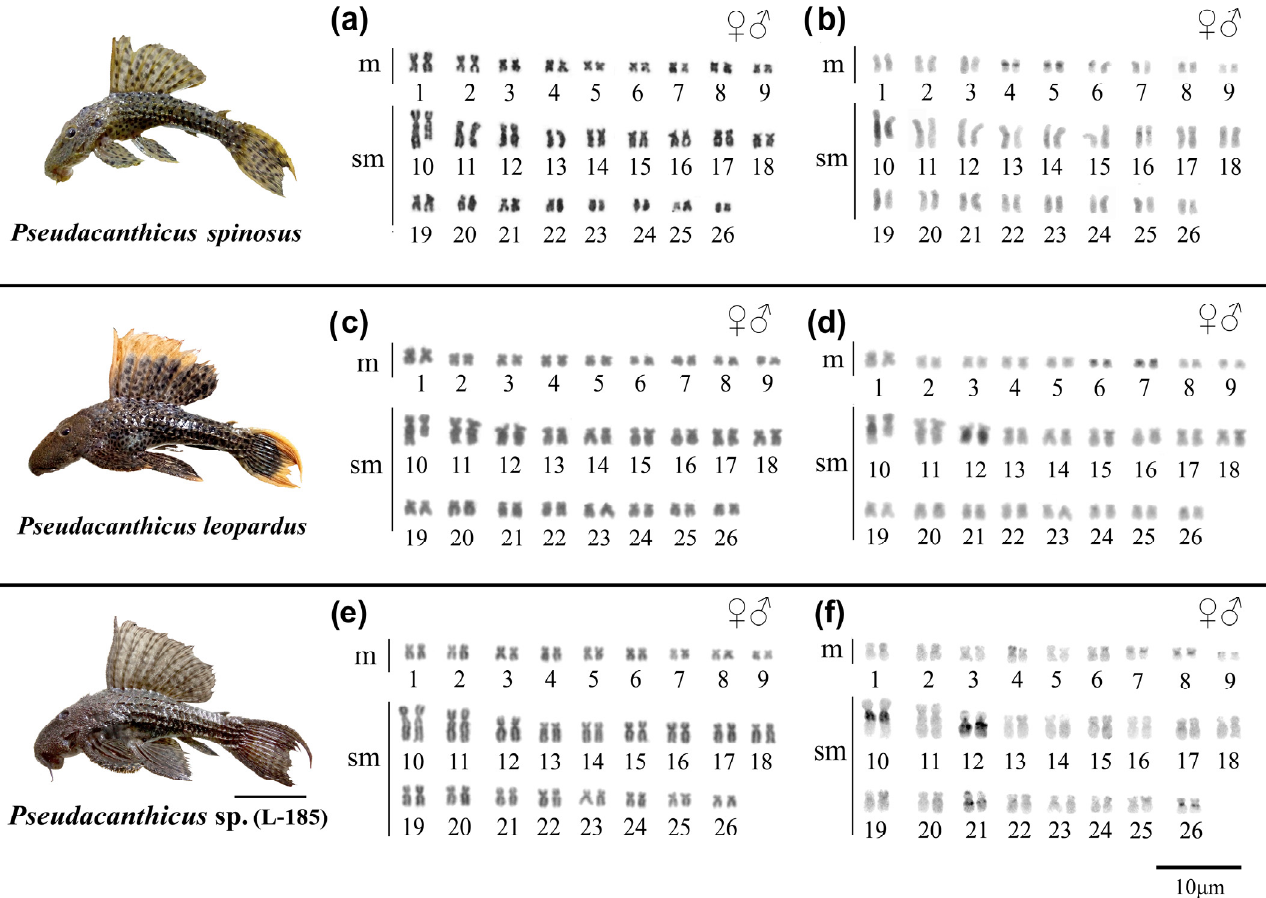
Figure 1. Karyotypes of Pseudacanthicus species. In ( a , b ) karyotypes of P. spinosus ; in ( c , d ) karyotypes of P. leopardus ; and in (e, f ) karyotypes of Pseudacanthicus sp. after conventional staining with Giemsa and C-banding, respectively. The external coloration patterns of the analyzed Pseudacanthicus species are shown on the side, scale bar: 5 cm. Photos by Kevin Santos da Silva. Table 2. Chromosomal data of the Pseudacanthicus species analyzed in this study.